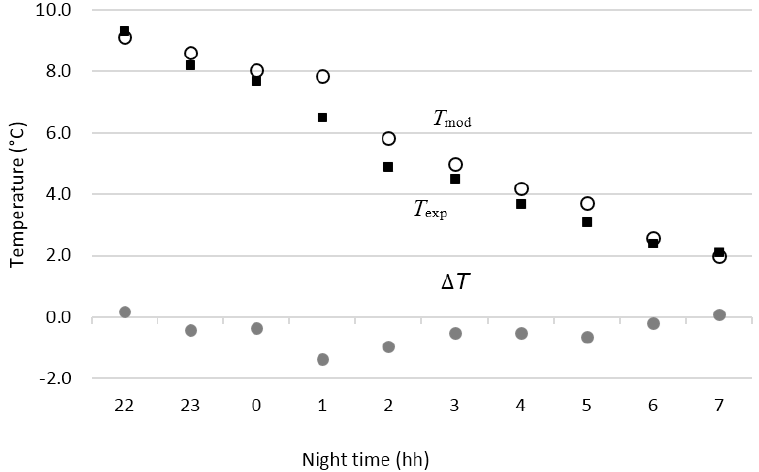
Figure 9. Comparison of the theoretical and experimental wpRC surface temperature.